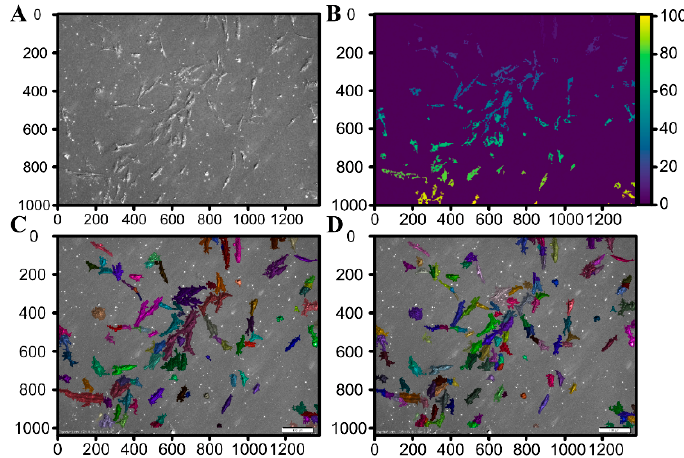
Figure 10. The process of image analysis for an exemplary image ( A ) (10× magnification). In ( B ), unique colors mark individual seeds for the segmentation algorithm. In the resulting images ( C ) and ( D ), colors mark separate regions created by the watershed segmentation algorithm. Figure 11. The outcome of the Feineigle-based method for an image ( A ) (40× magnifica-tion). In the resulting image ( B ), colors mark separate regions created by the watershed seg-mentation al- gorithm.